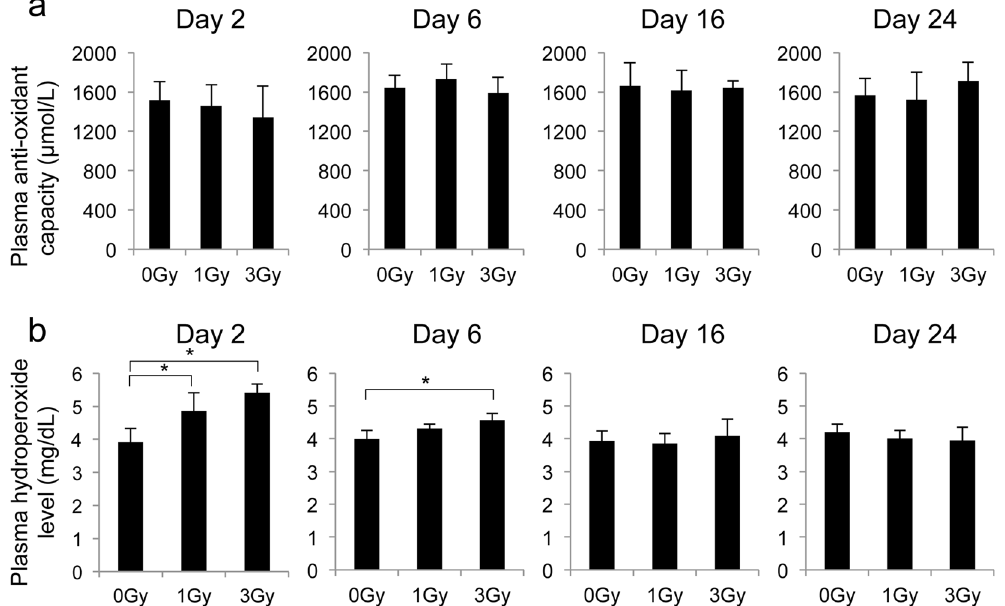
Figure 3. Changes in plasma anti-oxidant capacity and hydroperoxide level after irradiation. ( a , b ) Plasma anti- oxidant capacity ( a ) and hydroperoxide level ( b ) were measured by an i-Pack Oxystress Test. All quantitative data are presented as the means ± SD (n = 3–4). * P < 0.05, Welch’s t